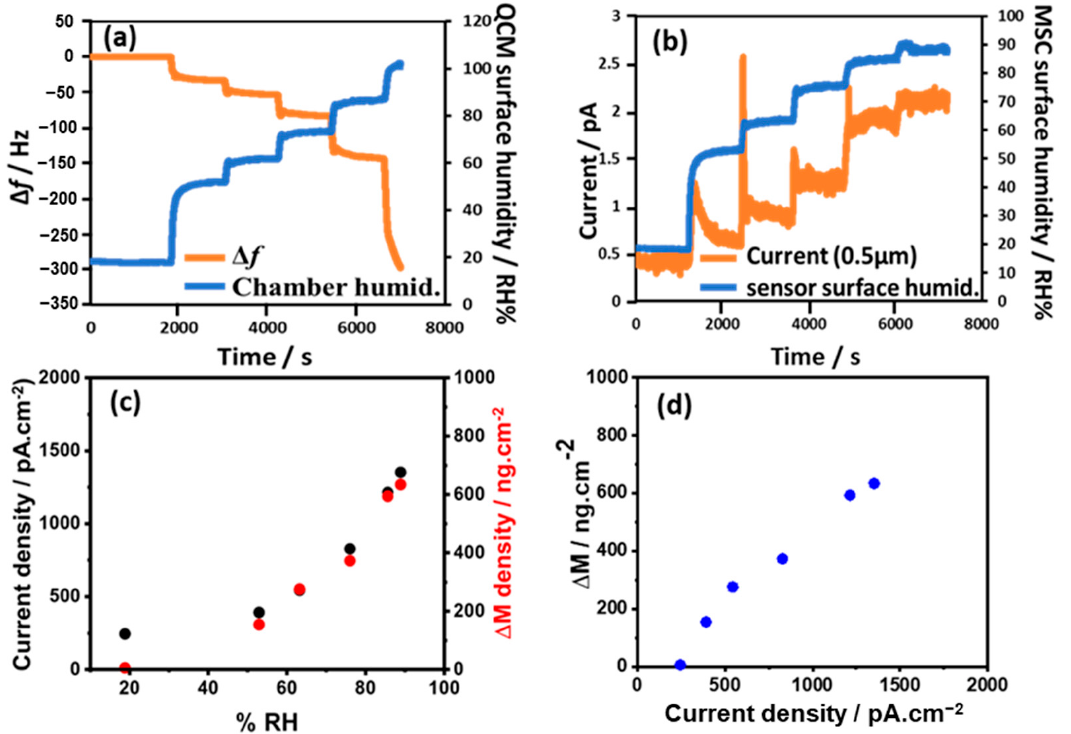
Figure 3. Detected frequency changes by QCM electrode ( a ) and detected response galvanic current by MSC ( b ) as a function of % RH. Linear correlation between mass per unit area and current density as a function of % RH ( c ). Linear correlation between current density and mass per unit area detected by QCM and MSC surfaces, respectively ( d ).